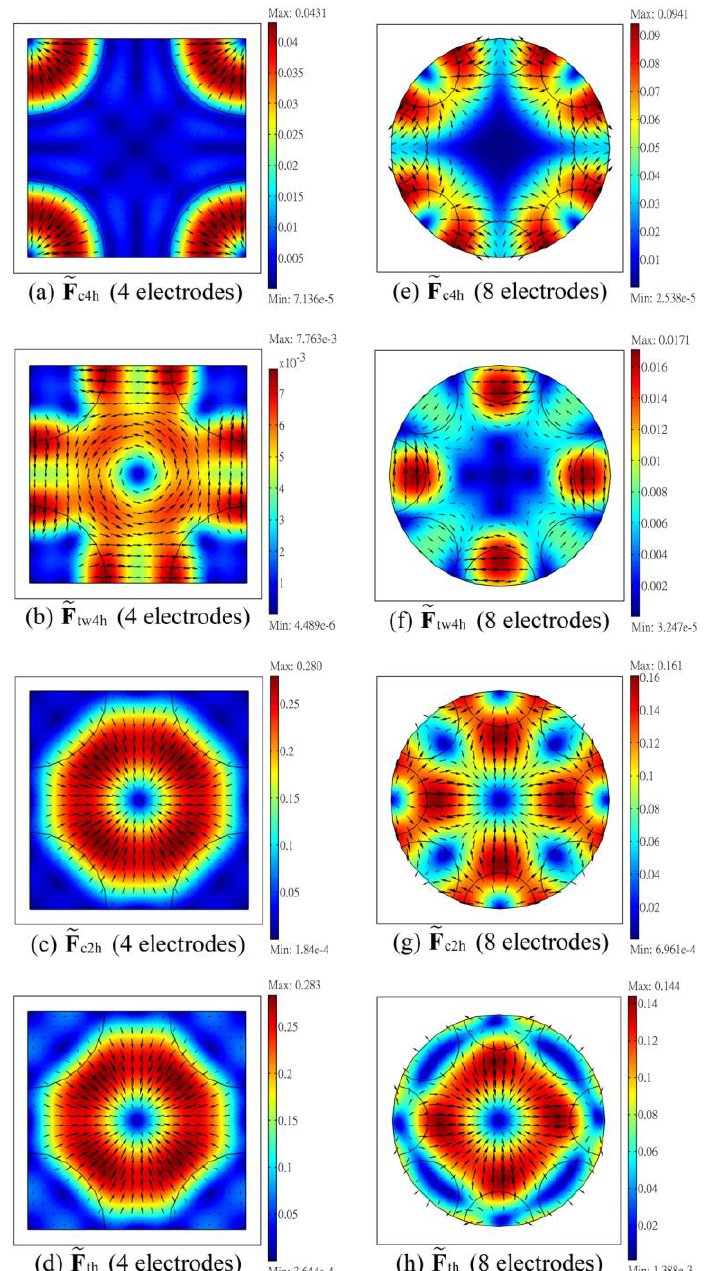
Figure 2. Distributions of dimensionless horizontal forces on the cell on a horizontal plane at height 40 µ m in the ER chamber for a typical case under negative dielectrophoresis (DEP). (cid:101) F c4h , (cid:101) F tw4h , (cid:101) F c2h and (cid:101) F th are the dimensionless horizontal conventional DEP force for the four-phase signal, the dimensionless horizontal twDEP force for the four-phase signal, the dimensionless horizontal conventional DEP force for the two-phase signal, and the dimensionless horizontal total DEP force for both signals, respectively. The results are for the case with Colo 205 cell in RPMI solution ( σ m = 1.2 S / m), calculated using V 4 = 1 V, = 20 MHz, K = − 0.1755 and K = 0.0604 for the four-phase signal, and V = 1 V, ω = 0.3 MHz and K r2 = − 0.256 for the two-phase signal. ( a – d ) are the results for the 4-electrode system, and ( e – h ) are those for the 8-electrode system. The projections of the electrode edges (part of a circle) on the plane are indicated in the figures, and the tip-to-tip distance of opposite electrodes, s, is 100 µ m for all the sub-figures. The forces are normalized using force scale, 2 πε m R 3 V 2 /s 3 . The maximum and minimum values are indicated at the upper and lower right corners of each sub-figure.